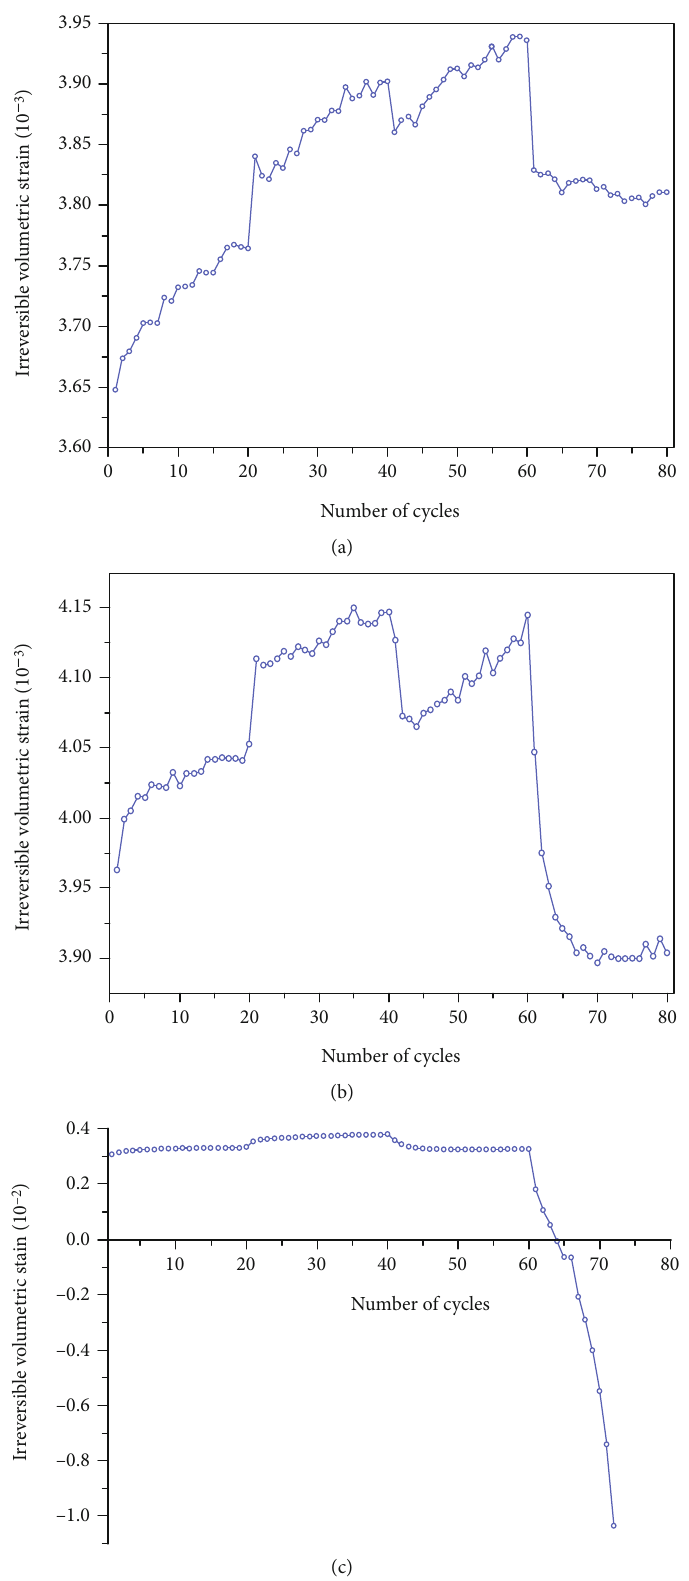
Figure 8: Evolution of irreversible volumetric strain with the number of cycles: (a) 0.1Hz; (b) 0.2Hz; (c)